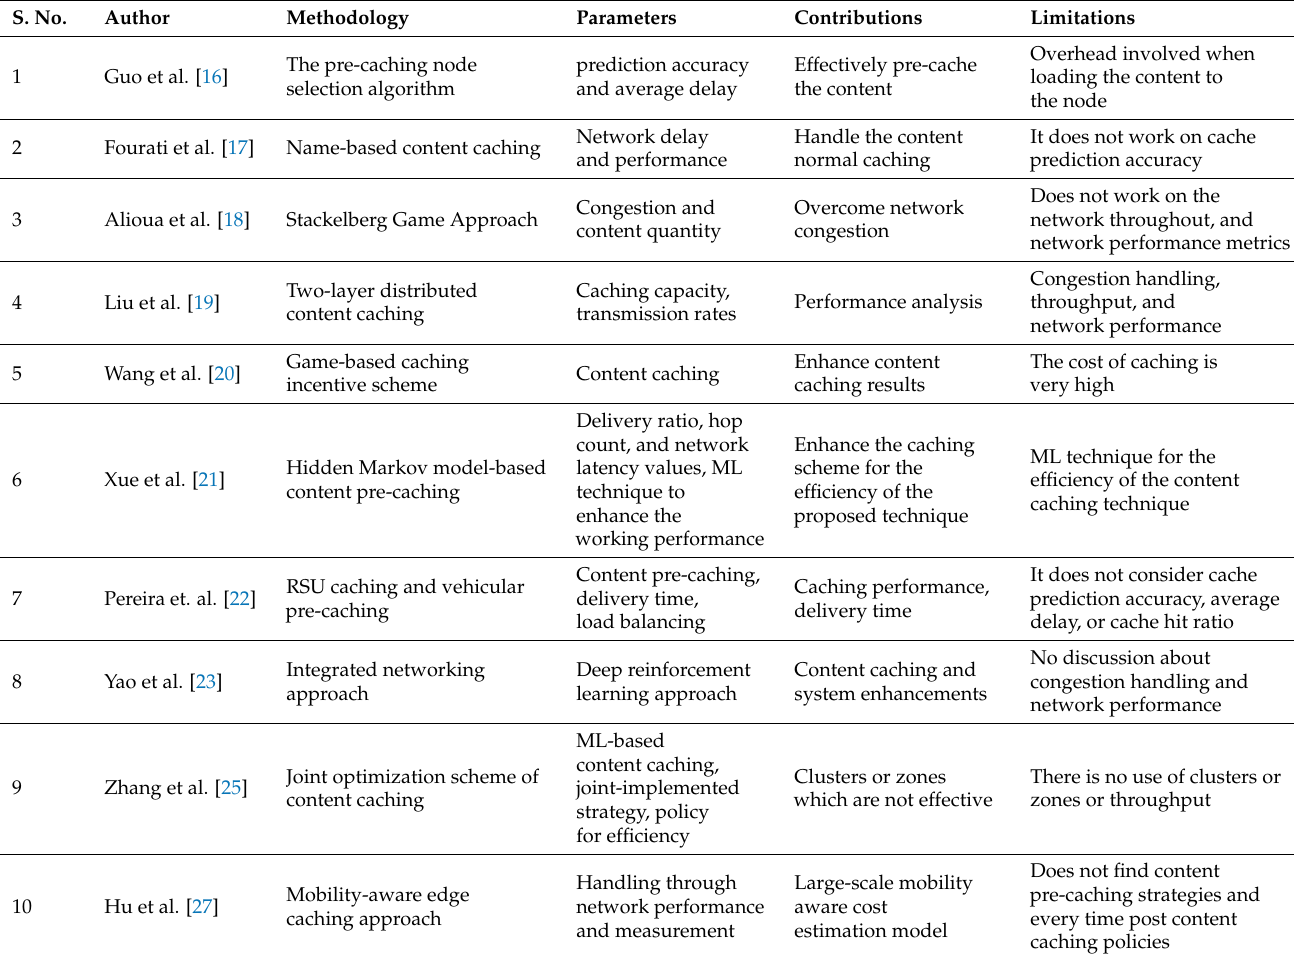
Table 1. Common limitations of the related works from the